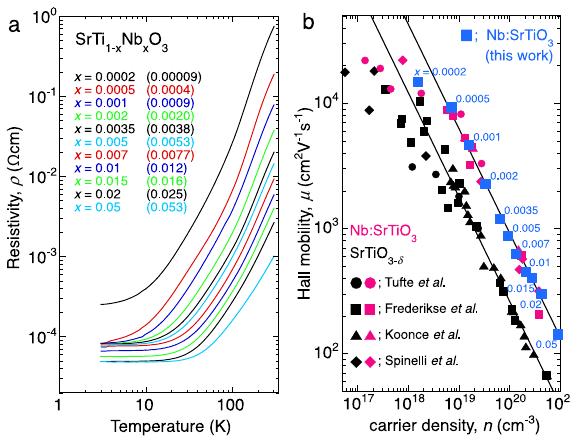
Fig. 1 Resistivity and Hall mobility of Nb:SrTiO 3 single crystals. a Temperature dependence of resistivity with nominal Nb content x values of 0.0002, 0.0005, 0.001, 0.002, 0.0035, 0.005, 0.007, 0.01, 0.015, 0.02, and 0.05 over the range from room temperature down to 3 K. The numbers of Ti 3 d electrons deduced from Hall effect measurements are noted in parentheses. b Hall mobilities of our samples at 5 K (blue symbols), along with those of SrTiO 3 − δ (black symbols) and Nb:SrTiO 3 (red symbols) (refs. 44,64 – 66 ). The solid lines represent the characteristics of a phenomenological model 67 , μ / n (cid:2) 5 fi ts the experimental data very 6 , that Nb:SrTiO 3 single crystals (i.e., the same samples studied in Fig. 1a) are shown in Fig. 2a. We de fi ned T c as the mid-point of the resistive transition, as described in ref. 4 and as shown in Fig. 2a. The upper and lower error bars were determined from the onset and end temperatures of the superconductivity. This de fi nition of T c is used throughout this work. The T c values are plotted as a function of the carrier density n at 5 K in Fig. 2b. The carrier density in the nonpolar metallic state shows little